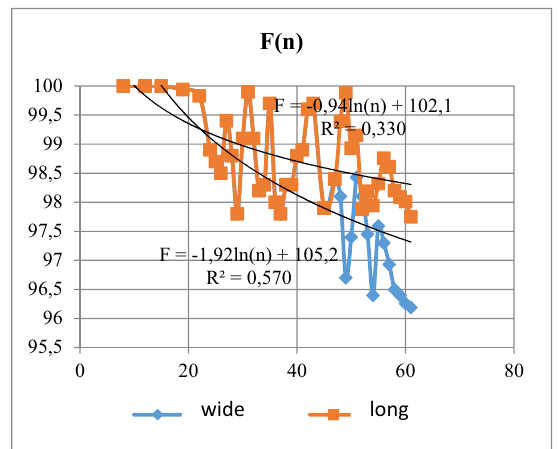
Figure. 4.1. Dependency of average value of the objective function on task dimension